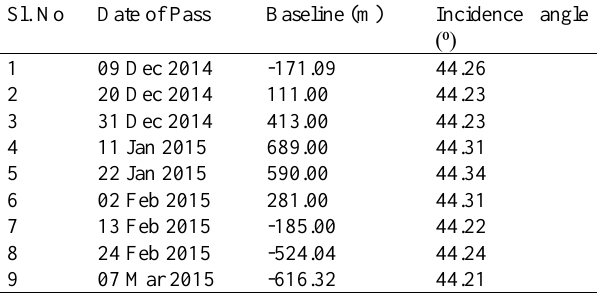
Table 1 Characteristics of TDM-X datasets utilized